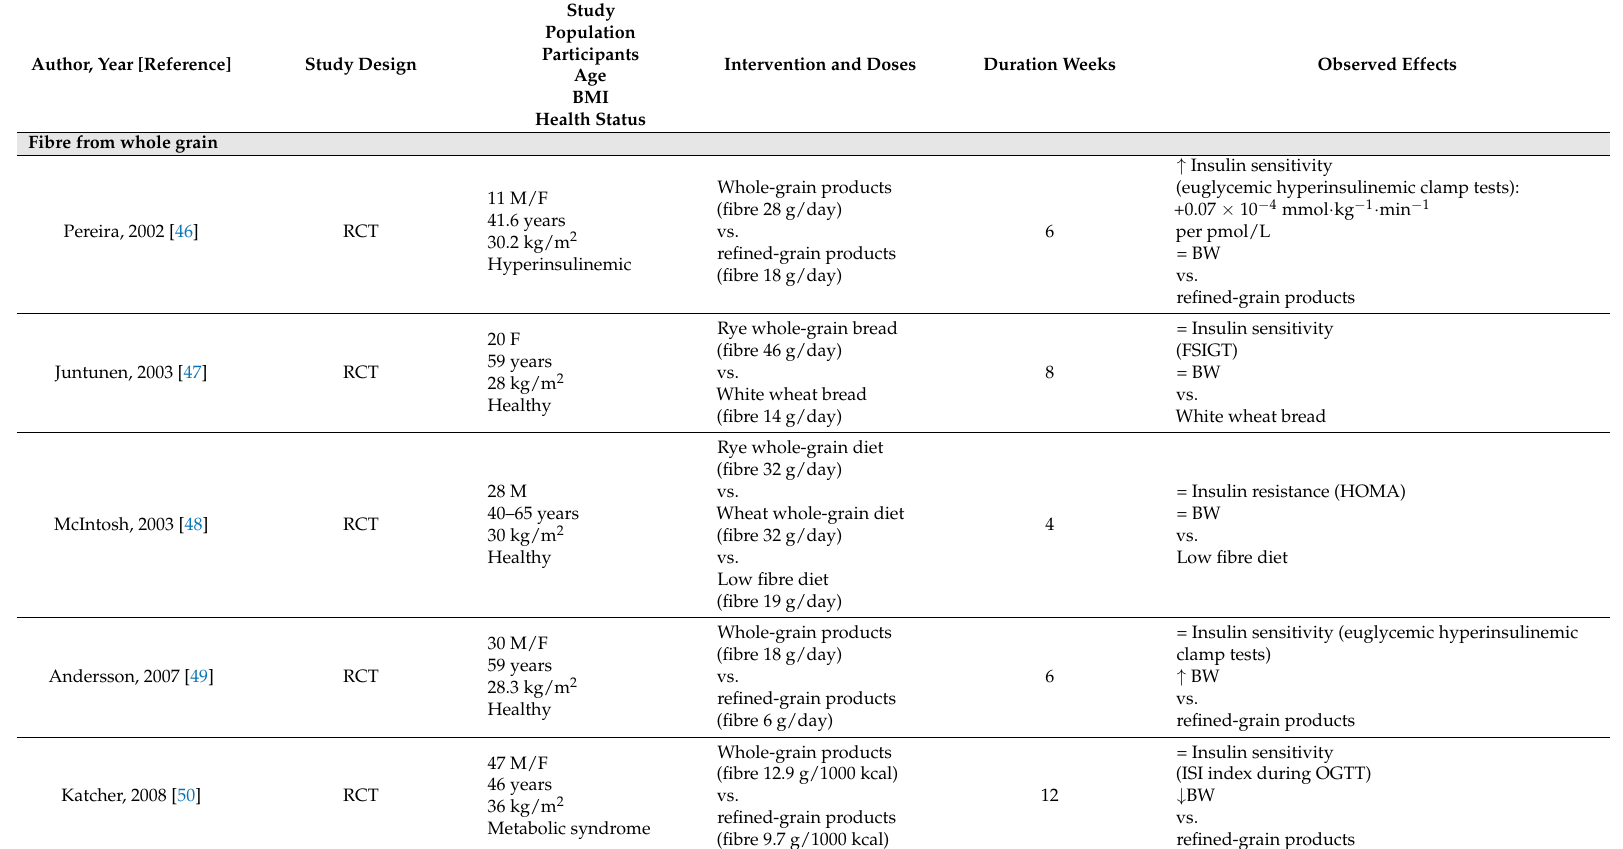
Table 3. Published RCTs evaluating the effects of fibre from whole grain or other sources on insulin